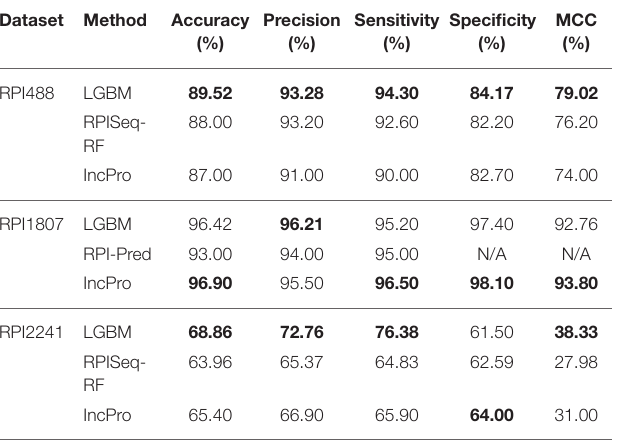
FIGURE 5 | The ROC curve of dataset RPI1807 on 10-fold cross- validation.